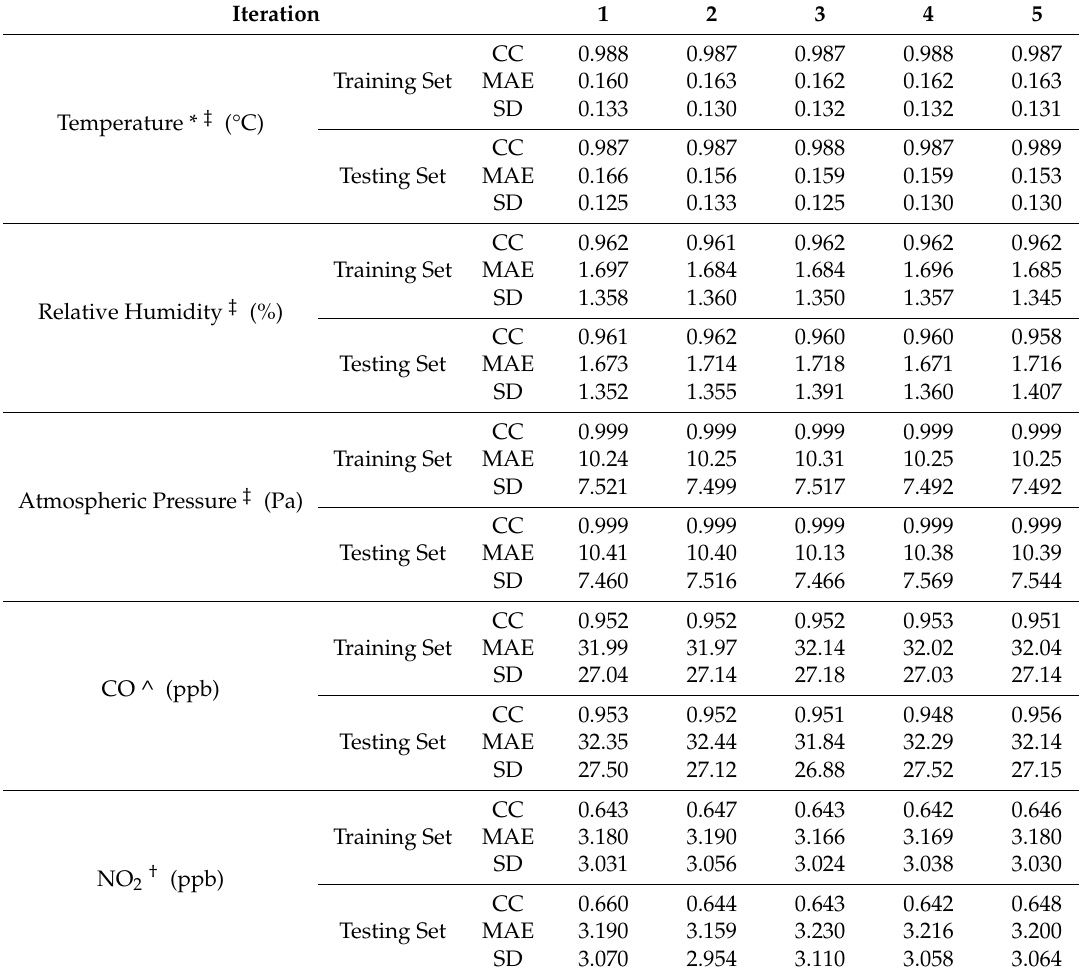
Calibration results of THP (temperature-humidity-pressure) Sensor-Module, CO Sensor-Module, and NO 2